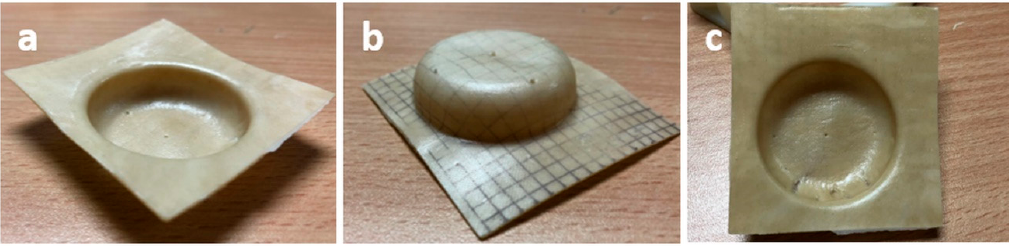
Figure 8. PHB / T_RH / HMDI thermoformed tray: ( a ) bottom-side view, ( b ) top-side view and ( c ) bottom view.